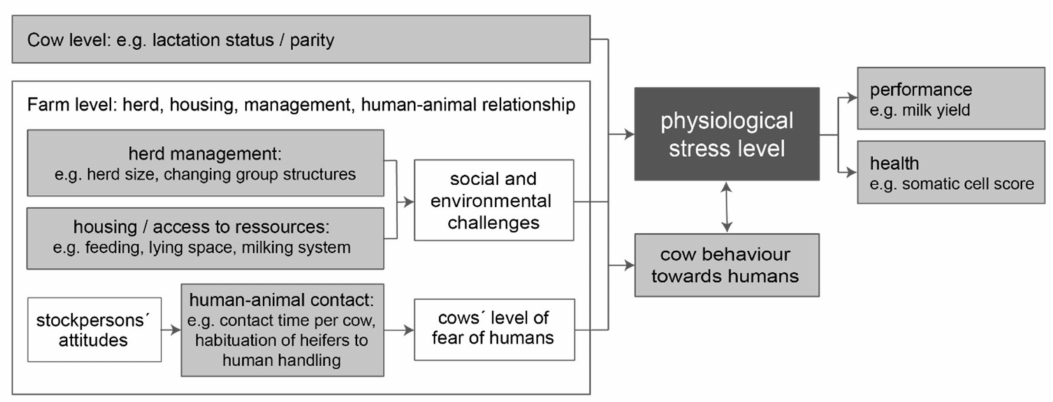
Potential associations between animal and farm factors, cows’ physiological stress levels, milk performance, and udder health (factors with gray background were considered in the present